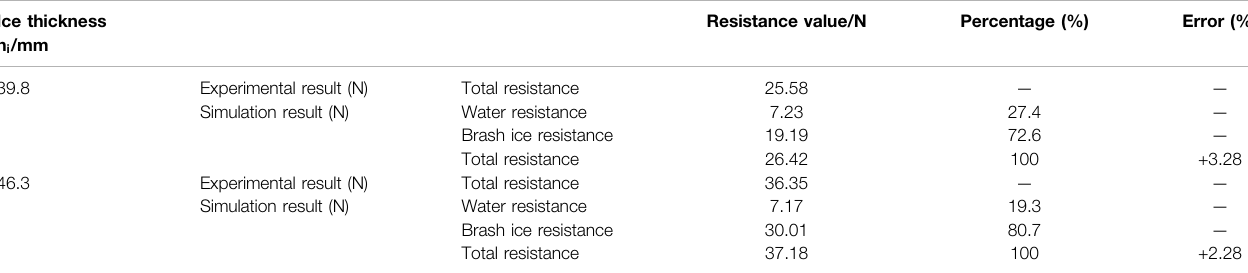
TABLE 5 | Brash ice resistance components and comparison with the test results.